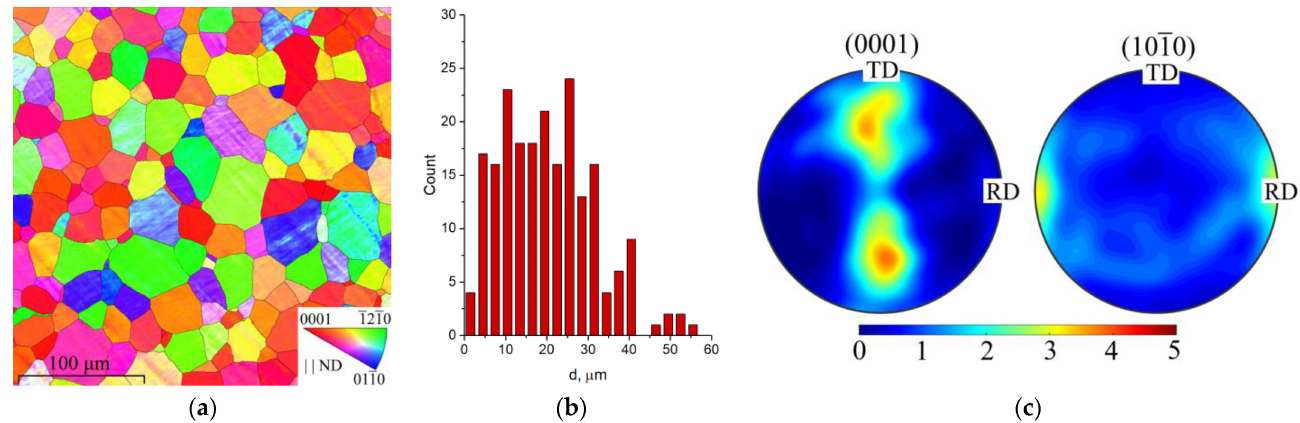
Figure 3. Microstructural data for commercially pure titanium: an EBSD map ( a ), the grain size distribution ( b ), and the (0001) and (1010 ) pole figures ( c ).